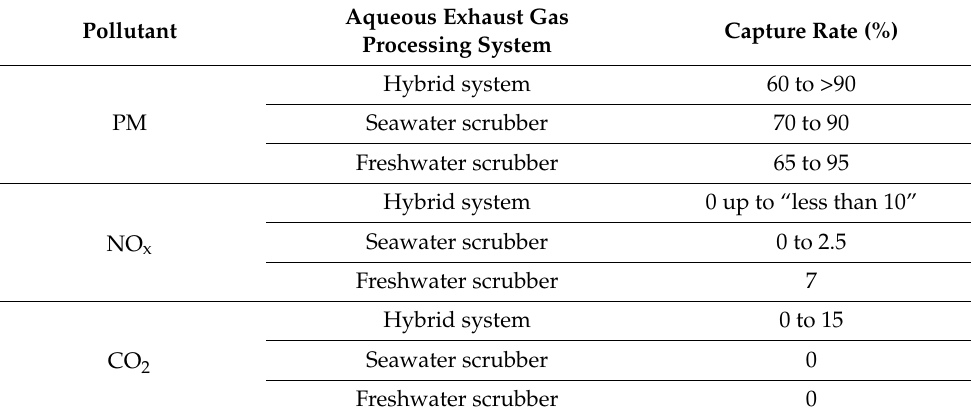
Table 4. PM, NO x and CO 2 capture rates from aqueous exhaust gas processing systems coupled to marine diesel engines. The classification of the capture rates is conducted according to the type of aqueous exhaust gas processing system. (All values have been derived from available data of manufacturers of corresponding systems, and the table was genuinely generated using data from ref. [32]). Aqueous Exhaust Gas Pollutant Capture Rate (%) Processing System Hybrid PM